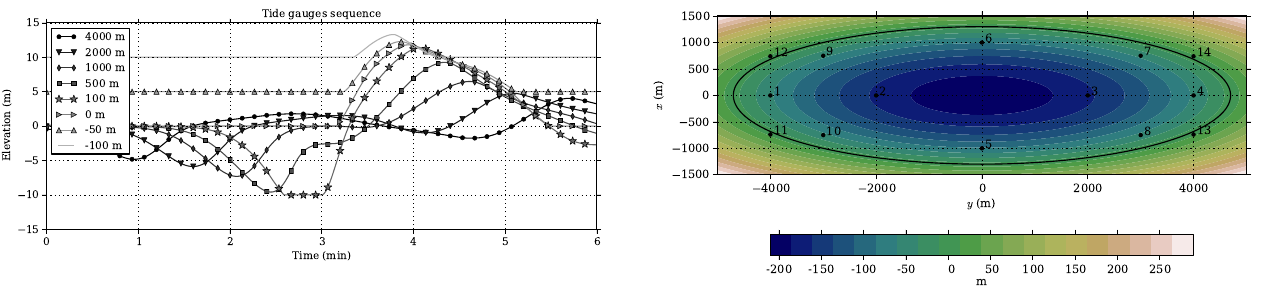
Fig. 8. Benchmark n. 2: contouring of the topo-bathymetry of the paraboloidal basin and positions of the calculated tide-gauge records. The black line is the coastline in still water conditions, i.e. an ellipse with semi-axes L = 4700m and l = 1300m. Tide gauges form couples symmetric with respect to the x- and y-axes. Exam- ples of x symmetric couples are (5, 6), (7, 8), (9, 10), and examples of y symmetric couples are (1, 4), (2, 3) and (7, 9). Some of these nodes are in deep water and always remain wet, while others like the couples (11, 12) and (13, 14) belong to the wet-dry